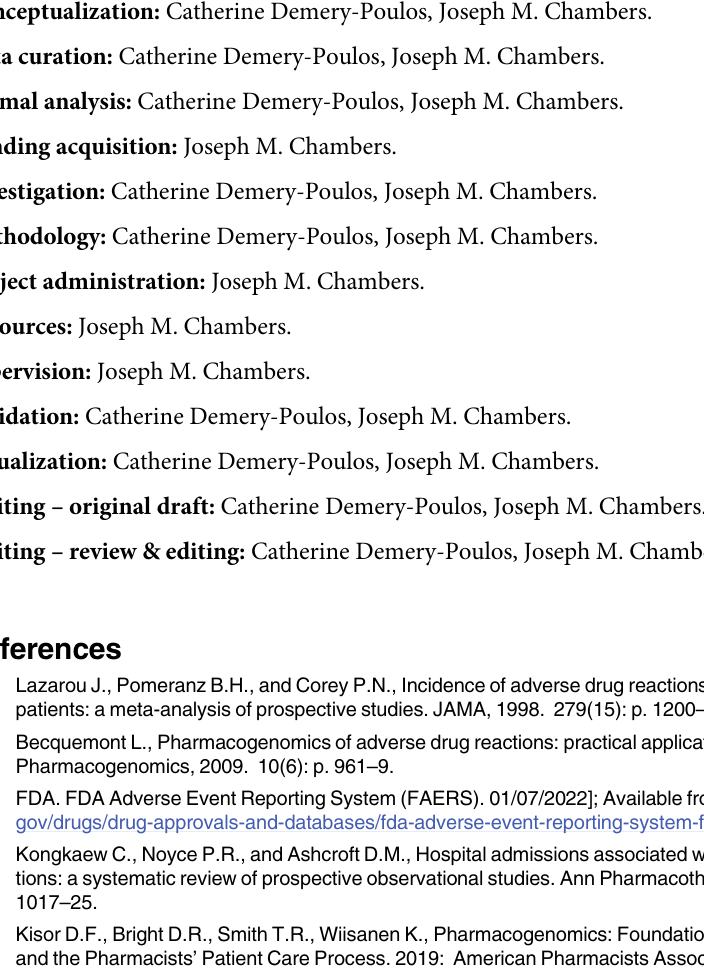
S3 Fig. Sequence alignment example. Here we provide an example of the most similar (in terms of amino acid sequence) Tier 2 gene (HMGCR) to visualize the similarities amongst amino acids over the length of the